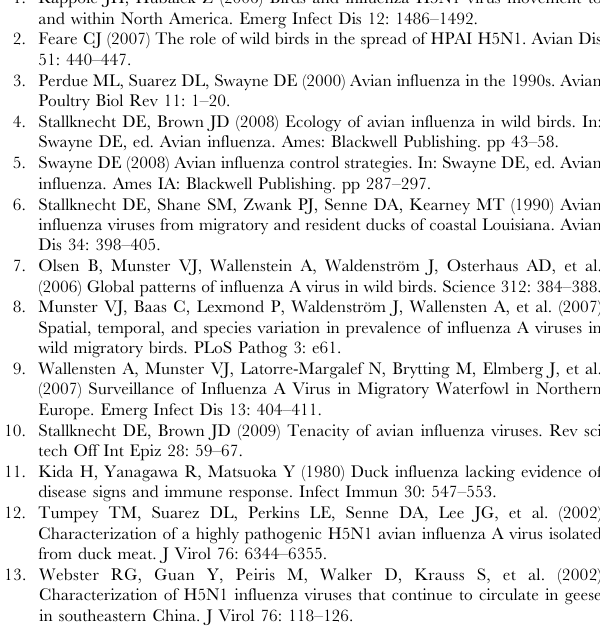
Table S1 Comparison of alternative parametric models for time to recovery and time to death. Akaike Information Criterion (AIC) values and number of model parameters (K) for alternative models of time to recovery and time to death from LP and HPAI laboratory challenge trials. Recovery data was modeled using an additive effect of age and virus pathogenicity (LP vs. HP). Time to death models only included HPAI-infected birds because LPAI infection did not cause mortality; these models also included the effect of age.